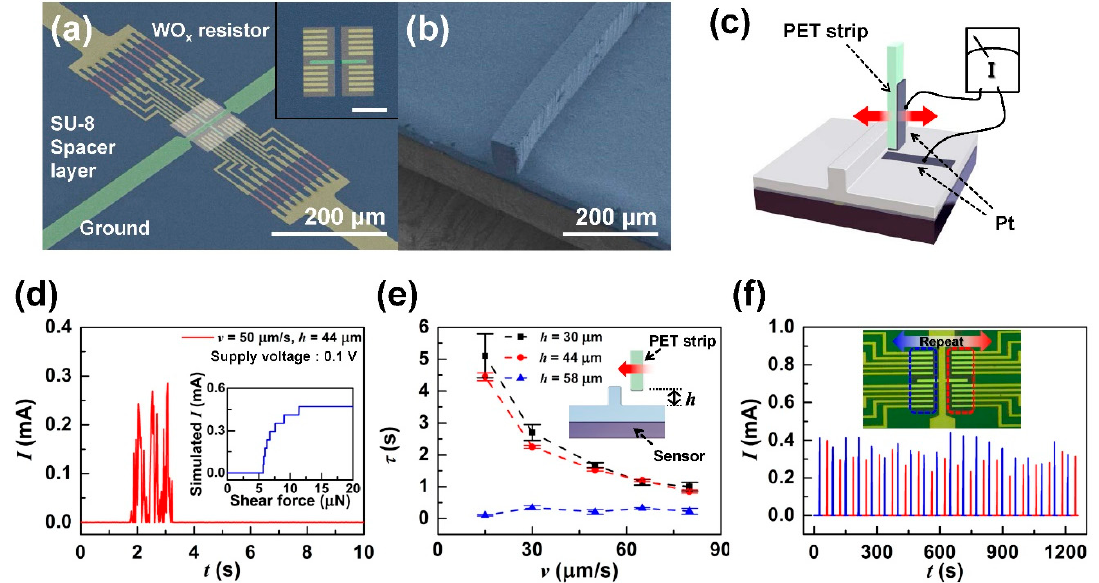
Figure 3. Basic characteristics of the tactile shear sensor: ( a ) false color scanning electron microscope (SEM) image of the fabricated bottom substrate that shows spatially digitized electrodes (yellow), resistors (red), ground electrodes (green) and spacers (blue). Inset image shows the false color SEM image of the spacer pit region taken at low accelerating voltage (tool bar indicates 50 µ m); ( b ) PDMS ridge structure with 30 µ m width and 60 µ m height; ( c ) schematic diagram of the measurement scheme for detecting contact height; ( d ) measurement result of the sensor by polyethylene teraphtalate (PET) strip scanning at 50 µ m/s scanning speed v and 44 µ m contact height h . Inset figure shows the simulated output current of the sensor depending on shear magnitude; ( e ) signal duration τ of the sensor dependent on h and v ; ( f ) real-time sensor output depending on alternating left (blue) and right (red) shear.